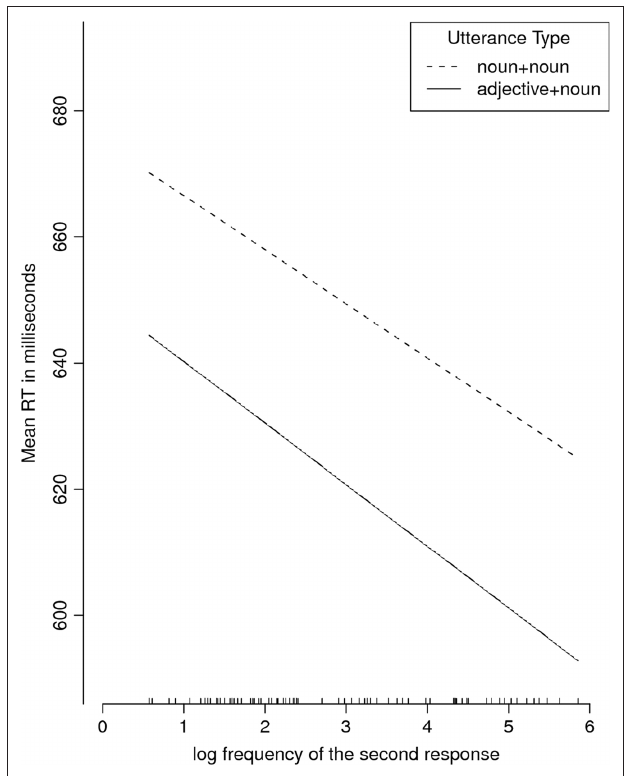
Figure 2 | graphical presentation of the effect of the (log) frequency of the second response in the noun + noun and adjective + noun naming conditions. Tickmarks on the x -axis represent the individual (log) values of the